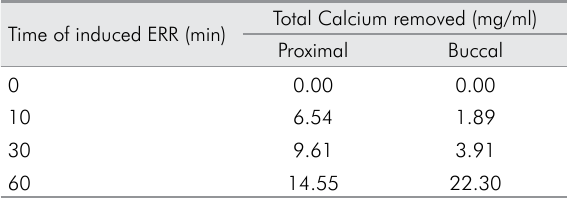
Table 1. Comparison between the total calcium removed and time of induced ERR for the proximal and buccal